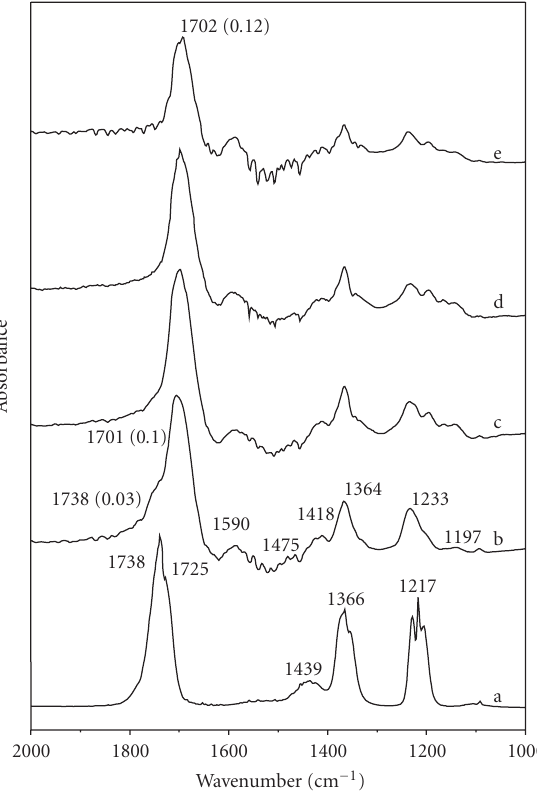
gion vibrational bands developed on sample H3 after exposure to 0.2 μ mol (14 μ molg − 1 ) of acetone vapor and recorded after a de- lay time of 2 minutes (curve (b)) and 15 minutes (curve (c)) and subsequent raising of sample temperature to 320K (curve (d)) and 360 K (curve (d)). Curve (a) shows corresponding vibrational bands of acetone vapor. The numbers given in the parentheses indicate the absorbance value of the particular IR